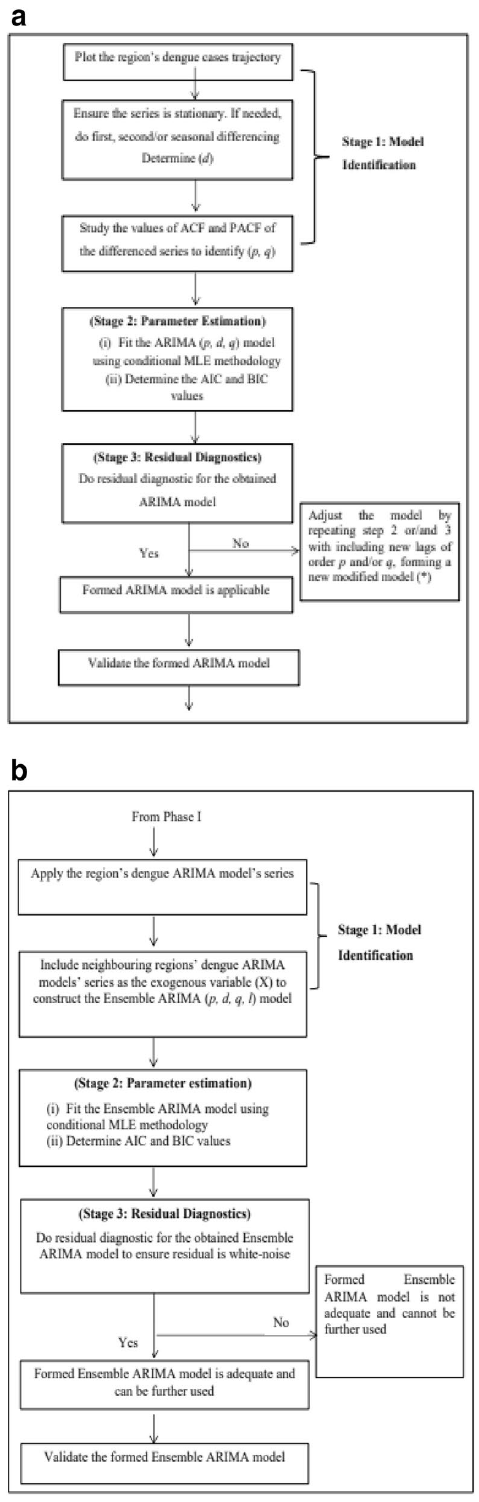
Figure 2. ( a ) Flow-chart of Box–Jenkins approach for ARIMA model development. ( b ) Flow-chart of Box– Jenkins approach for ensemble ARIMA model